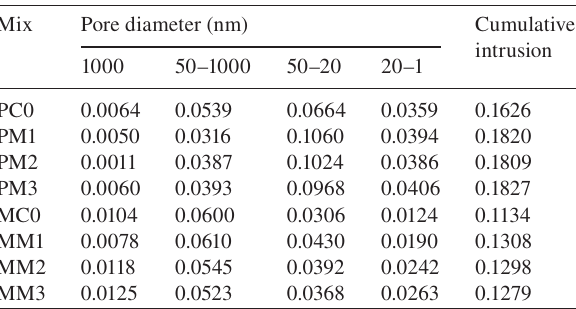
Table 6 Intrusion volume of mercury based on cement paste and cement mortar